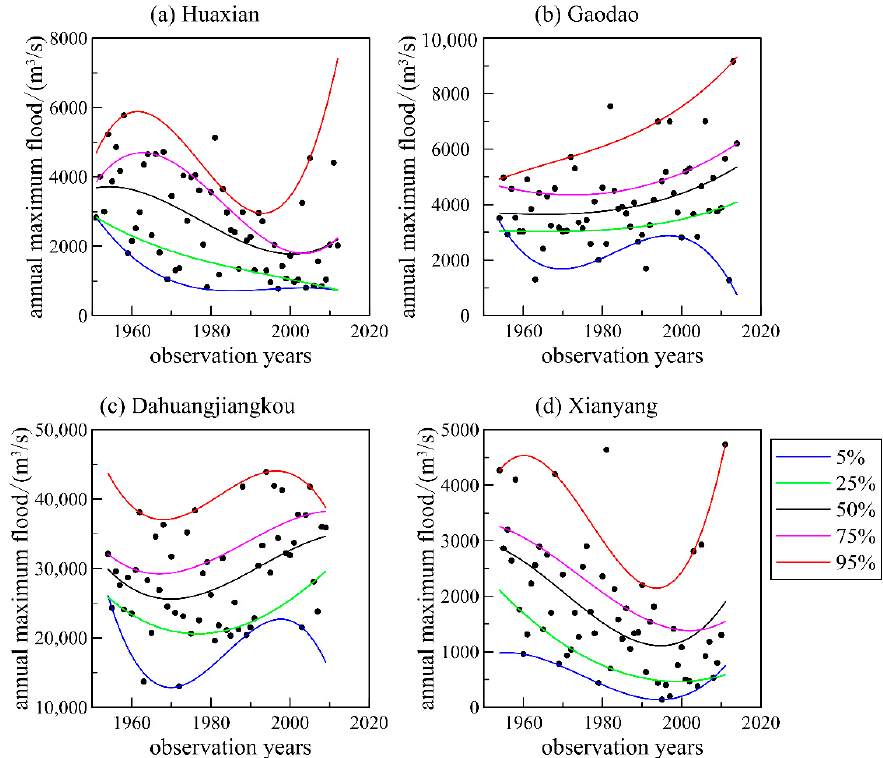
Figure 4. Quantile curves of QR-L model for ( a ) Huaxian station; ( b ) Gaodao station; ( c ) Dahuangjiangkou station; ( d ) Xianyang station.